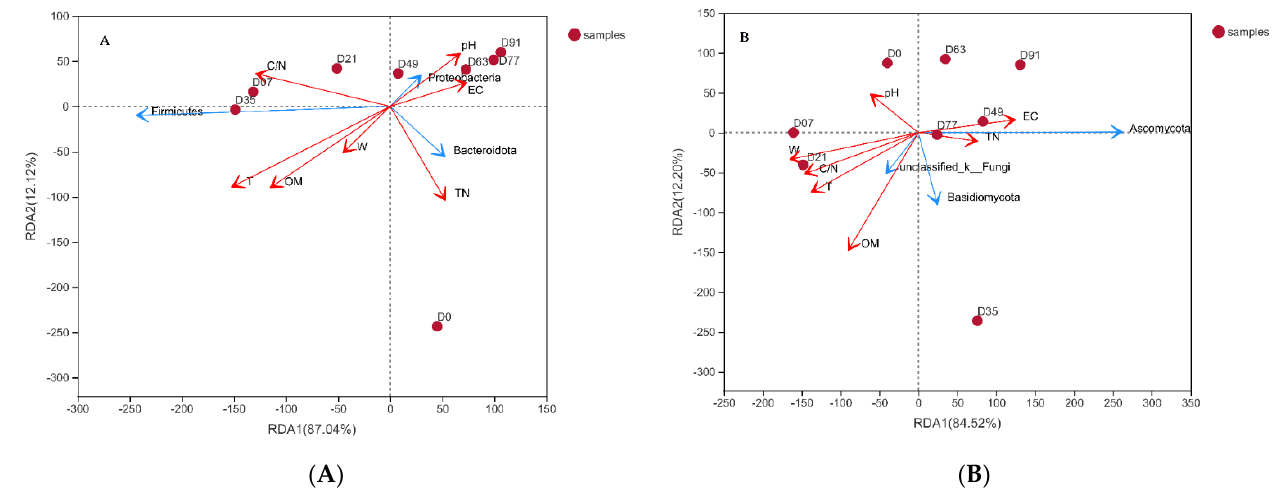
Figure 3. Redundancy analysis (RDA) of the bacterial ( A ) and fungal ( B ) communities and the environmental variables (W): water content; OM: organic matter; TN: total nitrogen; T: temperature). The environmental variables represented in the RDA are shown as red vectors in the plots. The dominant phyla of the bacterial and fungal communities are shown as blue vectors.